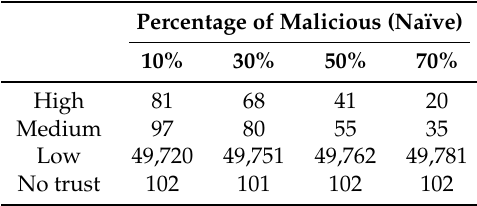
Table 8. Feedback reliability result with naïve